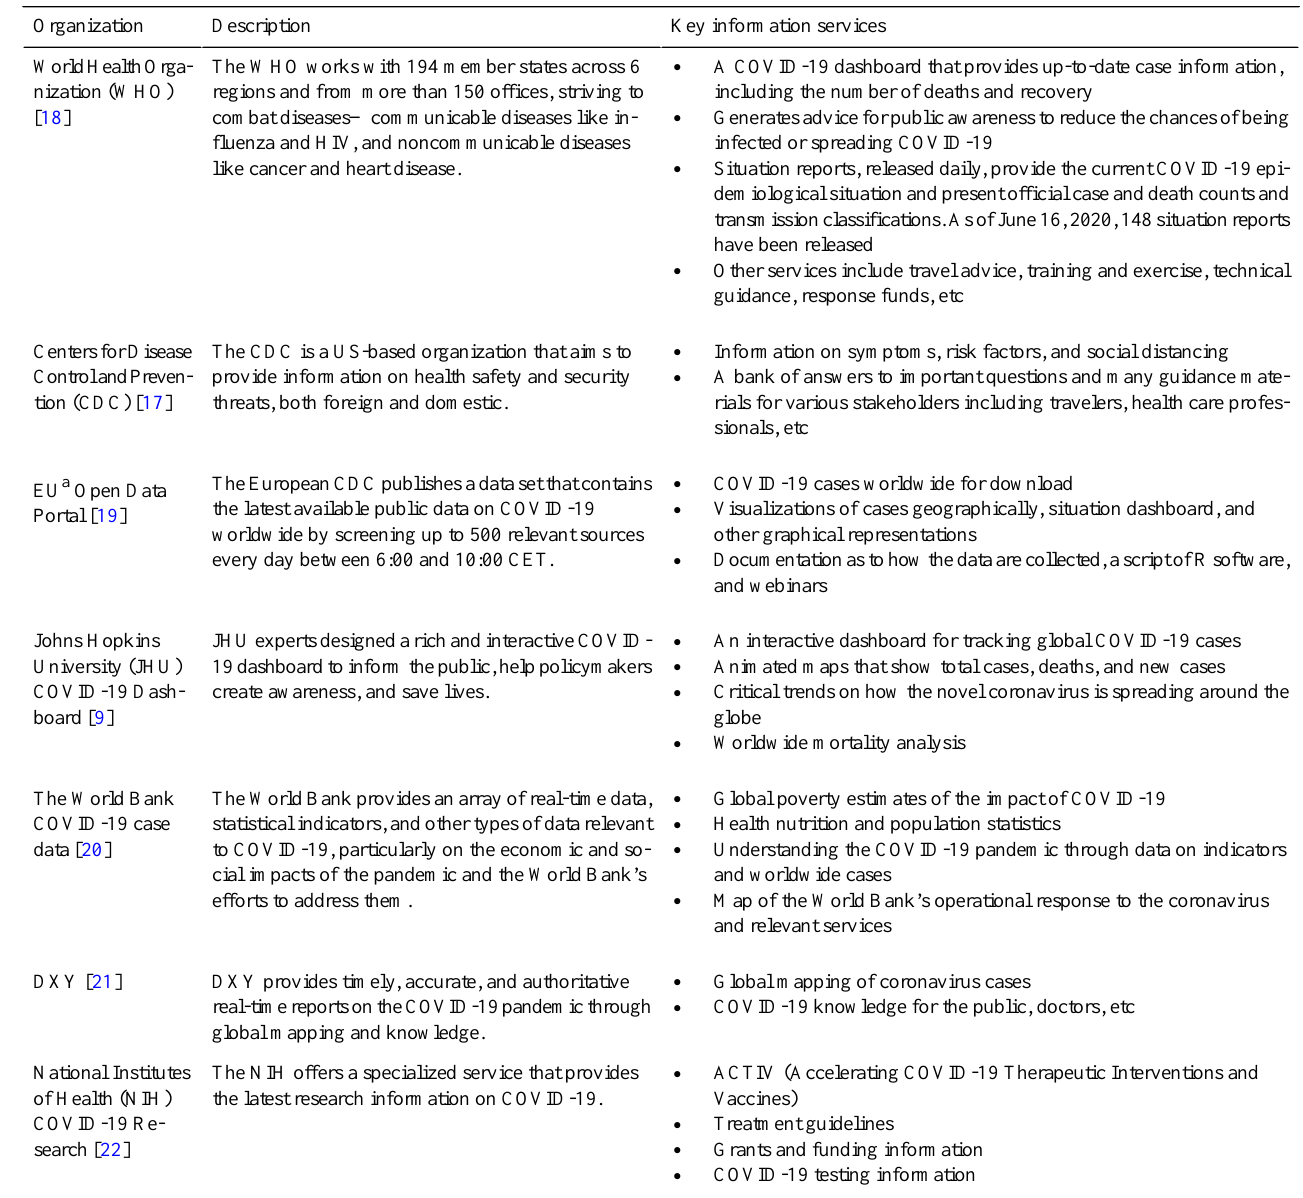
Table 2. A brief description of COVID-19–related information resources.